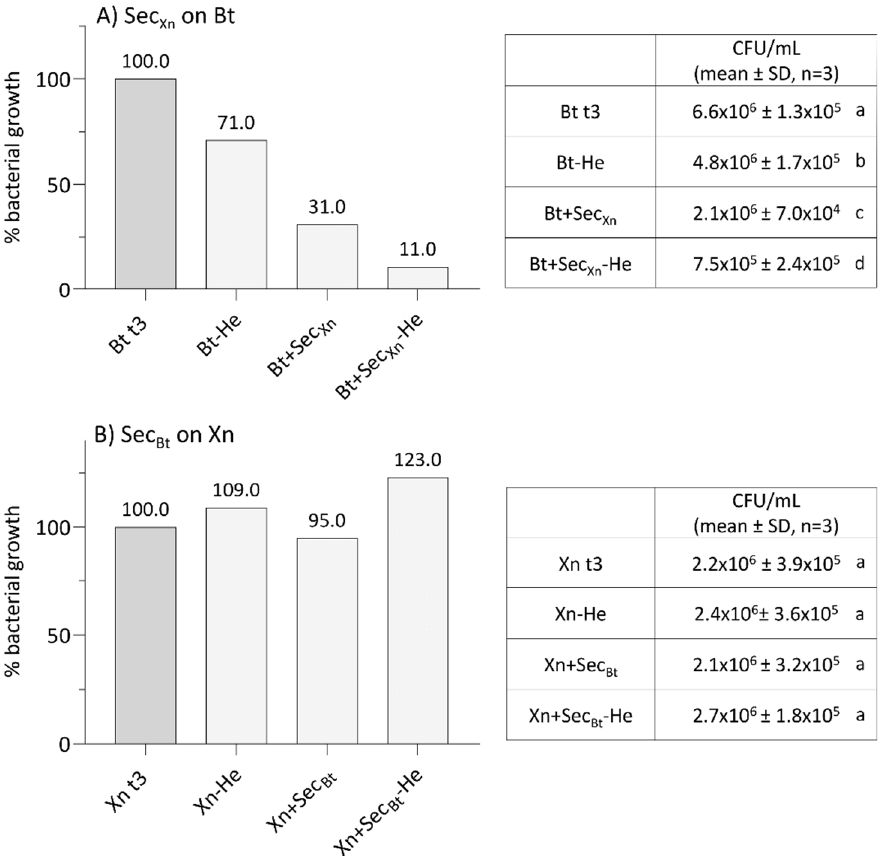
Figure 5. Analysis of bacterial growth of B. thuringiensis in the presence of X. nematophila secretions ( A ), and of X. nematophila in the presence of B. thuringiensis secretions ( B ), either in the presence or absence of SWD hemolymph. Bacteria were incubated for 3 h in the absence (panel A, Bt t3 and panel B, Xn t3) or in the presence of secretions (panel A, Bt+Sec Xn and panel B: Xn+Sec Bt ). Bacteria were also treated with secretions obtained from cultures grown in the presence of hemolymph CFH (panel A: Bt-He and Bt+Sec Xn -He; panel B: Xn-He and Xn+Sec Bt -He). In the assays the interference on the growth was observed only on Bt when in the presence of Xn secretions (panel A). Letters (a–d) indicate significant differences in the pairwise comparisons (Tukey test, p < 0.05).